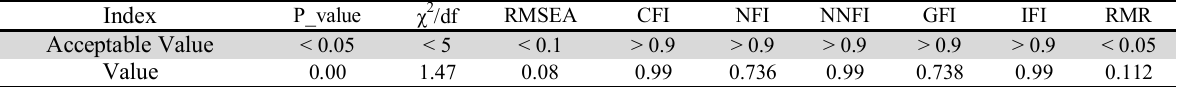
The summary of some basic statistics on SEM implementation